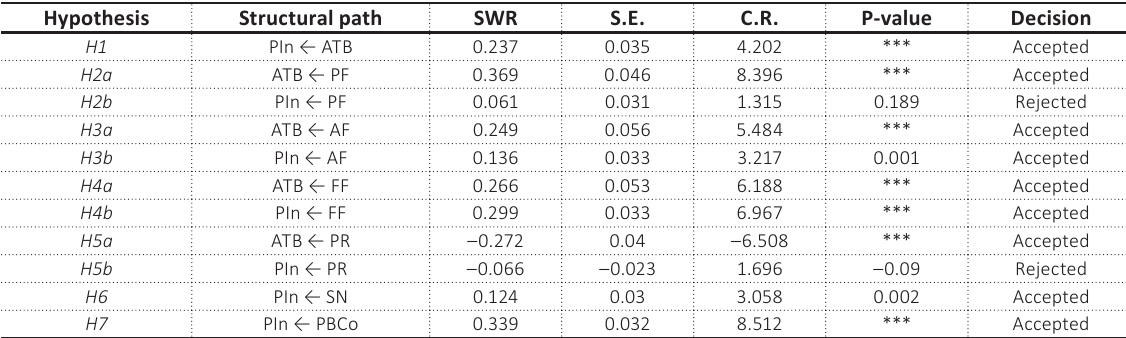
Table 5. Path analysis of SEM model